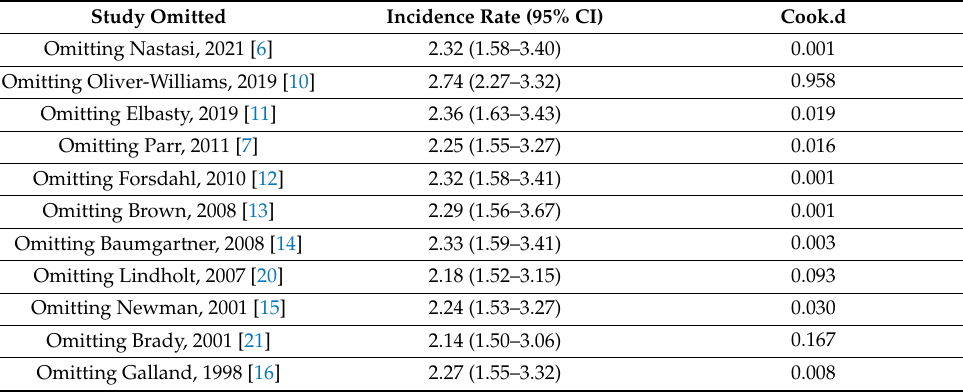
Table 4. Leave one out analysis of the incidence of cardiovascular death in patients with AAA.